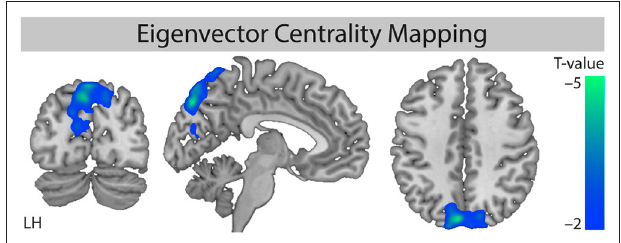
FIGURE 2 | Comparison of ECM values for the factor “stimulation.” Whole brain analysis for the contrast [stimulation vs. non-stimulation] shows decreased centrality for the stimulation conditions. Monte Carlo simulation with AlphaSim was used to identify significant clusters at pFWE < 0.05 (family-wise error correction for multiple comparisons). MNI slice coordinates X = − 5, Y = − 78, Z = 42. LH, left hemisphere.